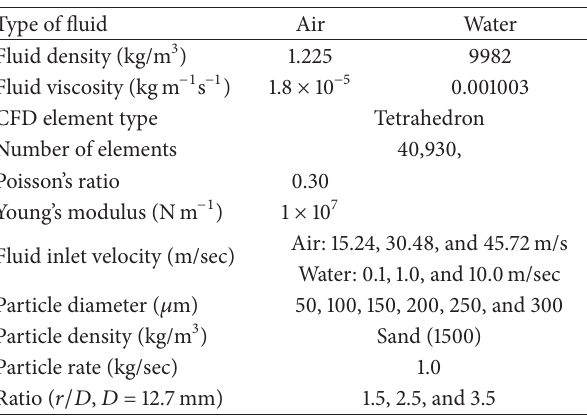
Table 1: Parameters used in CFD analysis.